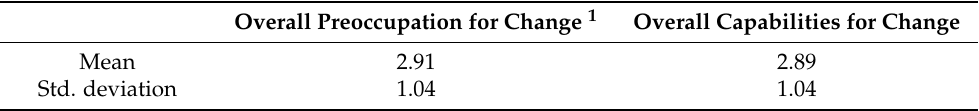
Table 2. Perceived preoccupation and perceived capability for turning towards RES–EP at the institution and community level. Overall Preoccupation for Change 1 Overall Capabilities for Change Mean